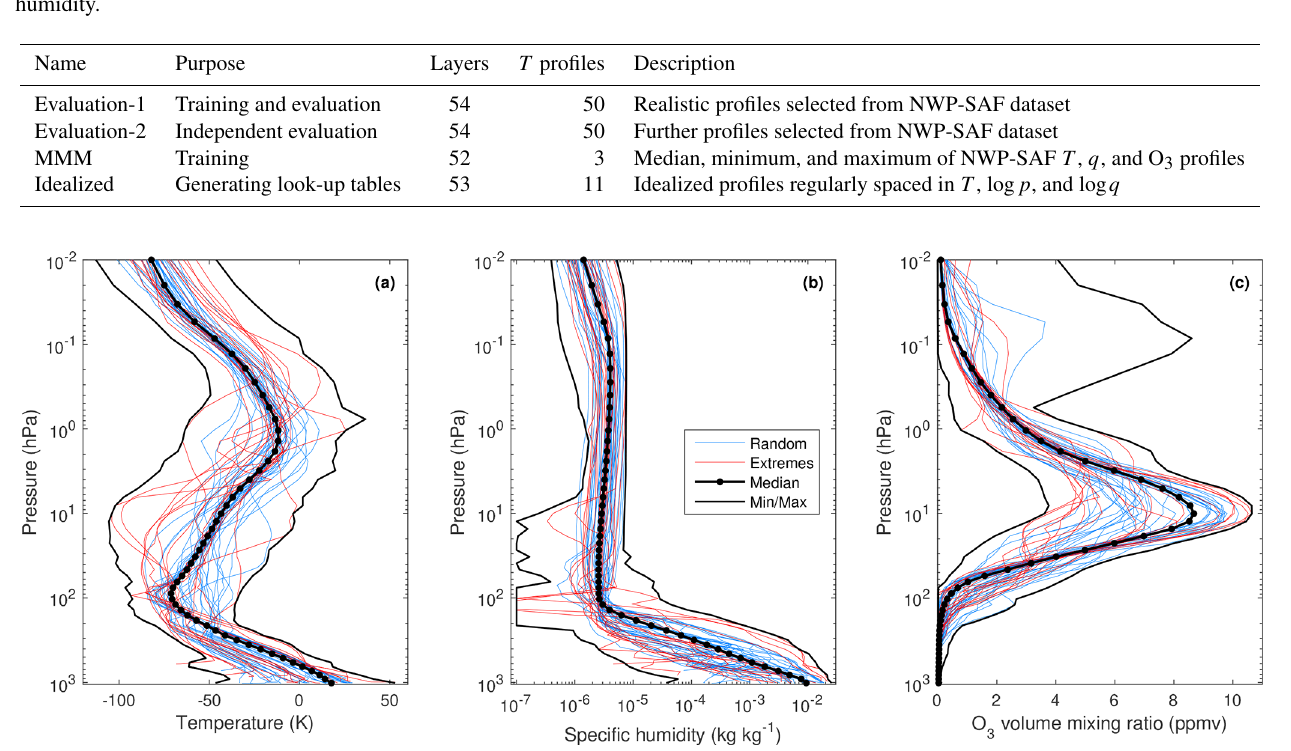
Figure 1. Vertical profiles of the temperature, specific humidity, and ozone concentration for the Evaluation-1 dataset described in Sect.